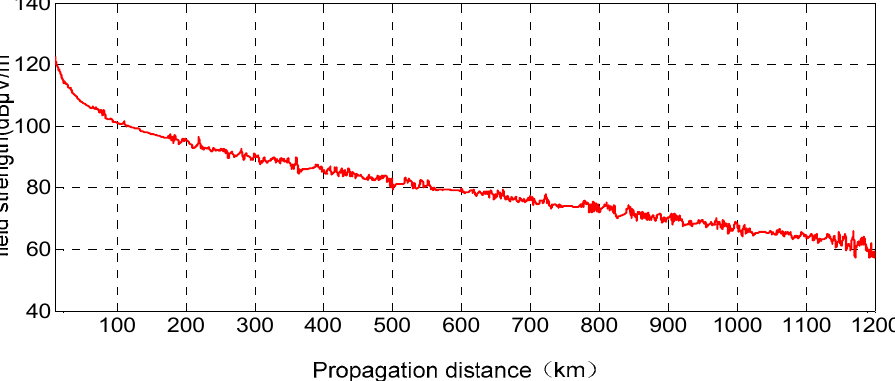
Figure 14. Field intensity propagation curve of the transmitted signal from the westward-oriented antenna.